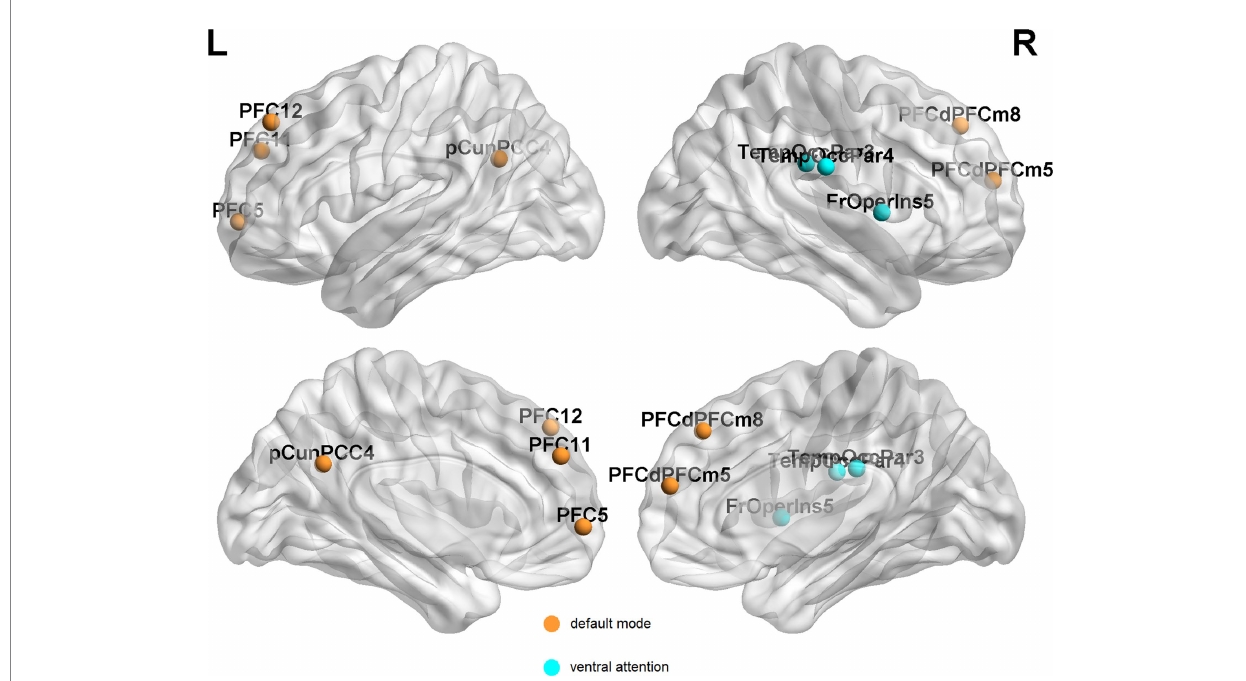
FIGURE 6 Brain regions with more than one graph metric changes after 1 year follow-up among EPRT- group. PFC, prefrontal cortex; pCunPCC, precuneus posterior cingulate cortex; PFCdPFCm, dorsal prefrontal cortex and medial prefrontal cortex; FrOperIns, frontal operculum insula; and TempOccPar, temporal occipital and temporal